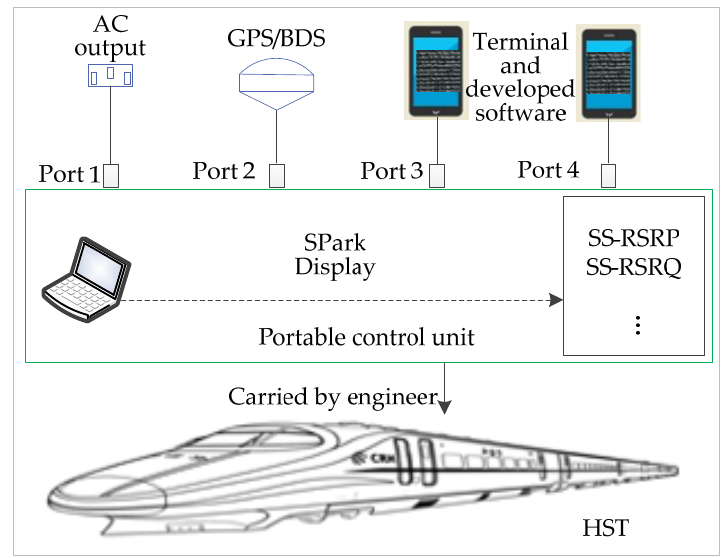
Figure 1. Principle of collecting massive amounts of measured data.